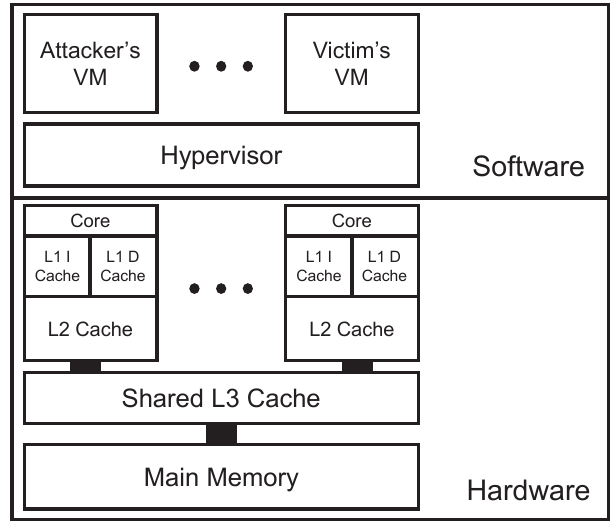
Figure 1. System model of the virtualized